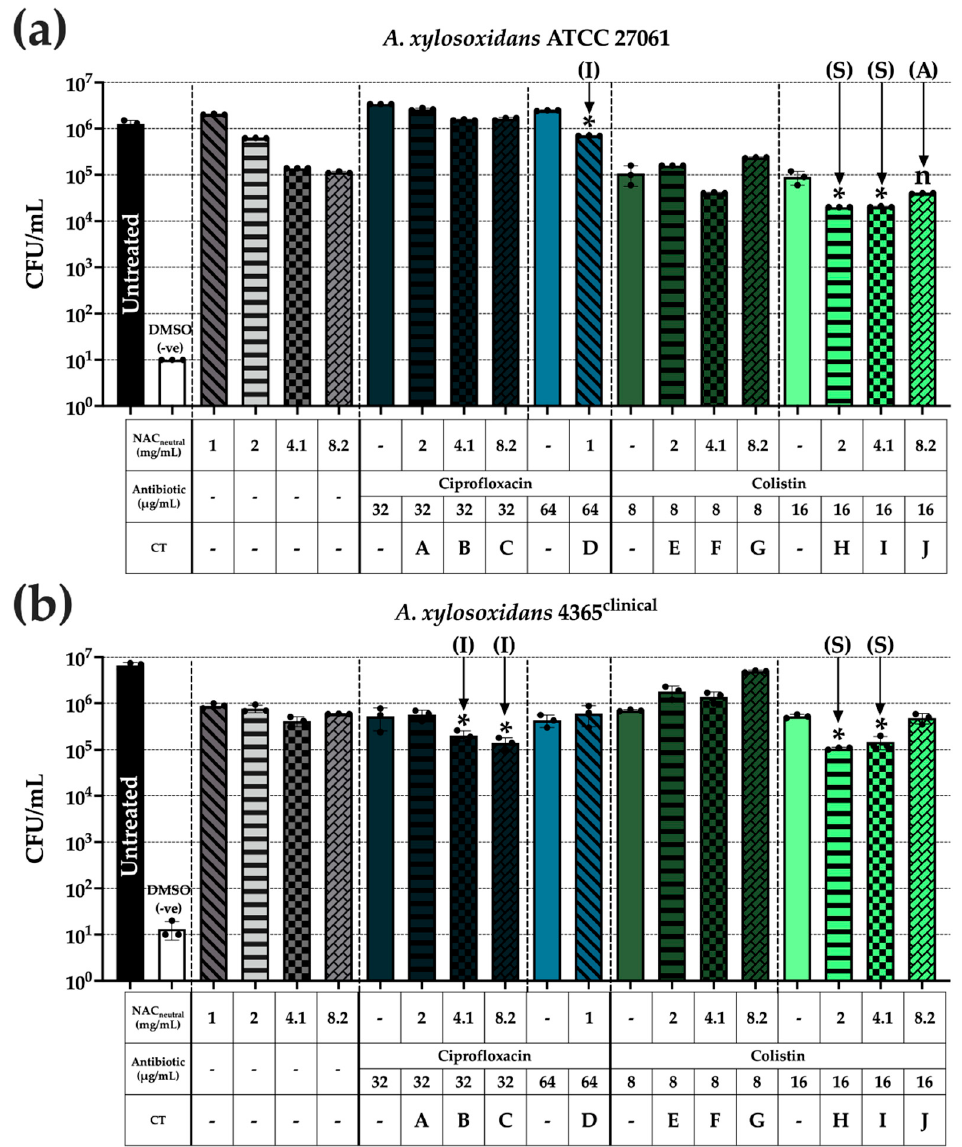
Figure 6. THP-1 cell invasion by A. xylosoxidans may be reduced with synergistic combinations of colistin. PMA-differentiated THP-1 cells were washed and infected with diluted bacterial cultures for one hour to allow for intracellular invasion. Following this, cells were washed thrice with 100 μ g/mL gentamicin before adding CT [6] in a final concentration of 20% ASMDM-1 and 80% RPMI medium for three hours. Cells were washed twice with 1 × PBS before being lysed and intracellular bacterial loads were enumerated using CFU/mL. Strains shown are ( a ) ATCC 27061 and ( b ) AX 4365. Correlation with planktonic synergy has been determined previously [6] and is denoted on relevant data as follows: ( S ), synergy, ( A ) additive, and ( I ) indifferent. (*) indicates the results are statistically significant ( p ≤ 0.05 (*) or not significant ( p > 0.05) (n) based on unpaired Student’s t -tests (with Welch’s correction). Experiments were performed in biological triplicate (n =